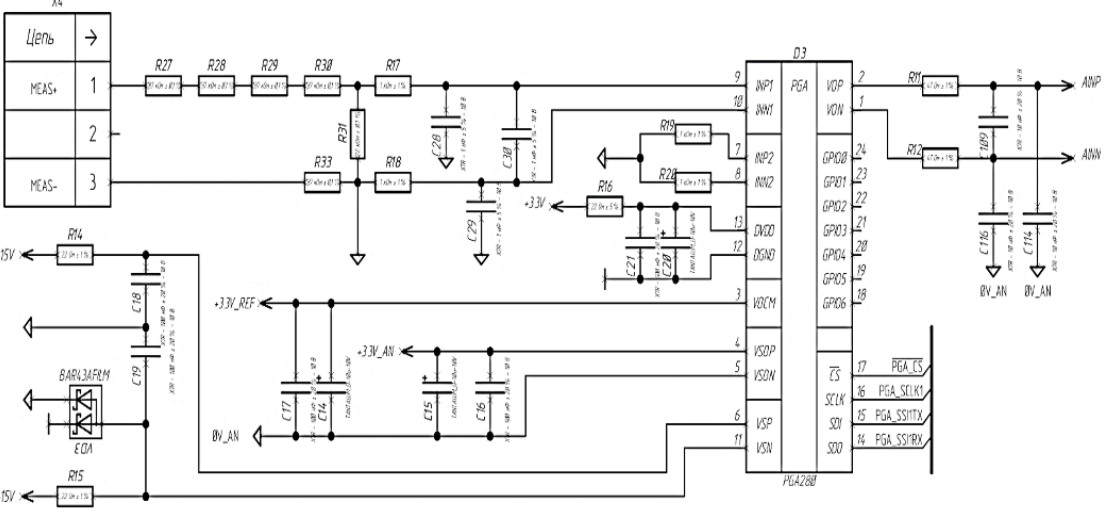
Figure 3. Scheme of electronic control board measurements.